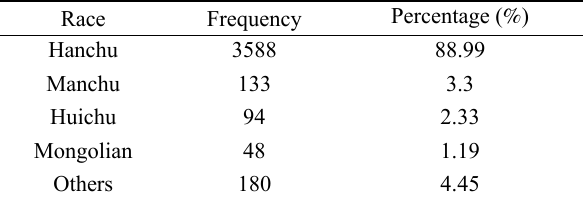
Table 3 Descriptive analysis of race factor.